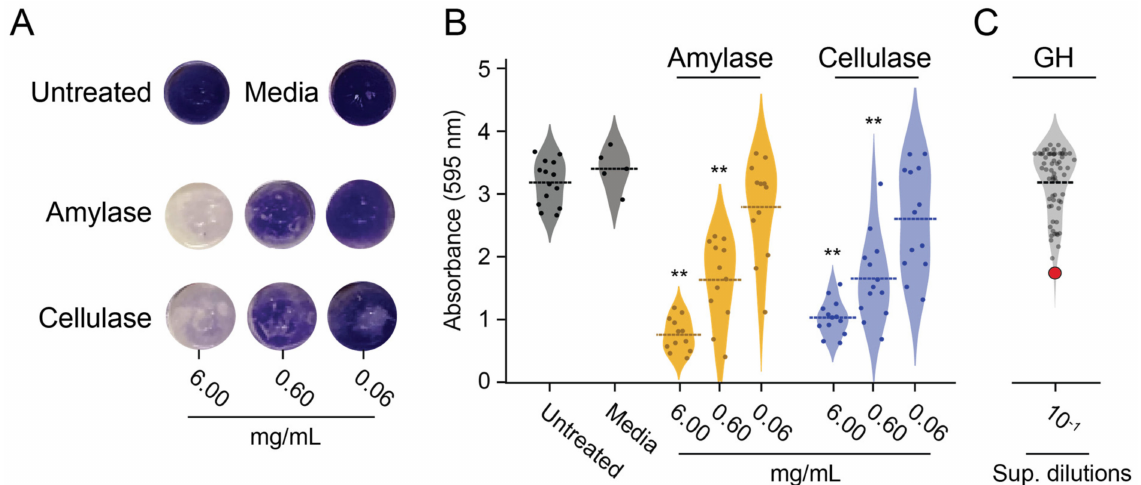
Figure 2. Activity of GHs in the P. pastoris culture supernatant against biofilms compared to com- mercial amylase and cellulase preparations. ( A ) Representative pictures of the dispersal of S. au- reus biofilms from polystyrene by commercial cellulase or amylase after staining with crystal vi- olet. ( B ) Quantification of the biofilm dispersion of commercial cellulase or amylase (6, 0.6, and 0.06 mg mL − 1 ) (** p < 0.01, Tukey’s test). ( C ) Quantification of biofilm disruption after the addition of a 10-fold dilution of the culture supernatant (Sup. dilutions) from 76 strains of P. pastoris that expressed recombinant GHs. The red point represents the α -xylosidase from position